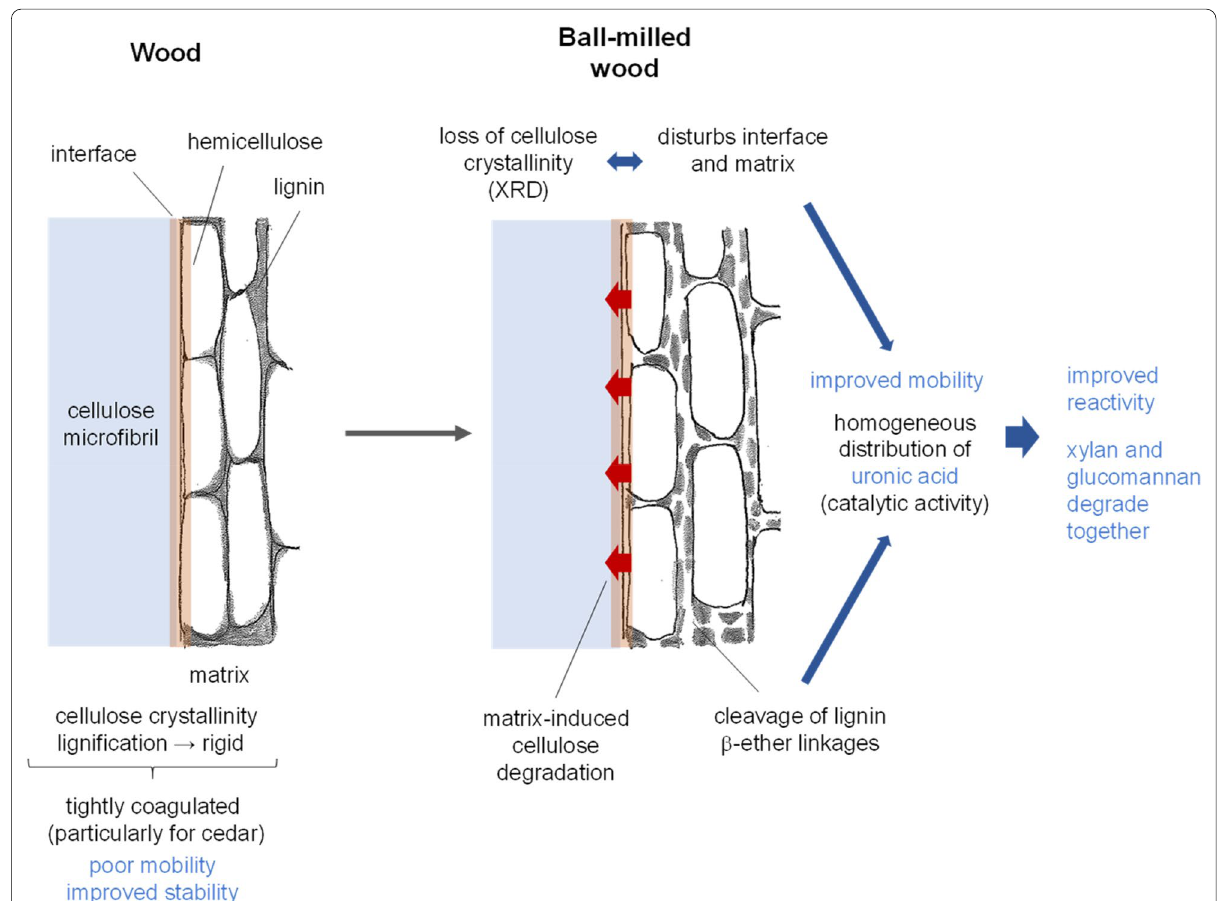
Fig. 11 Schematic images of the hemicellulose–lignin matrix and the interface with cellulose microfibril and their modifications expected to be caused by ball-milling